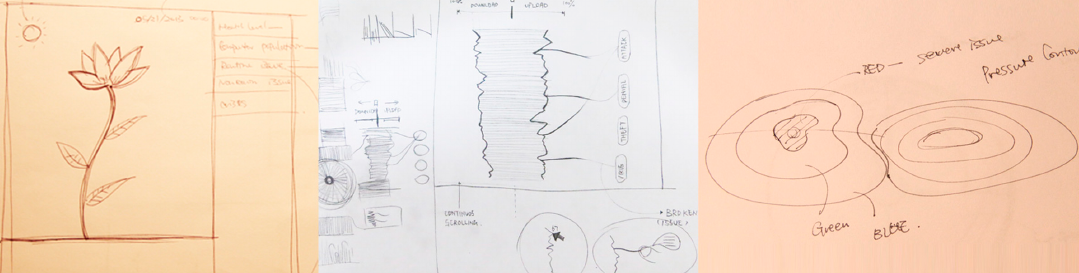
Figure 1 . Brainstorming visualization design ideas. Figure 1. Brainstorming visualization design